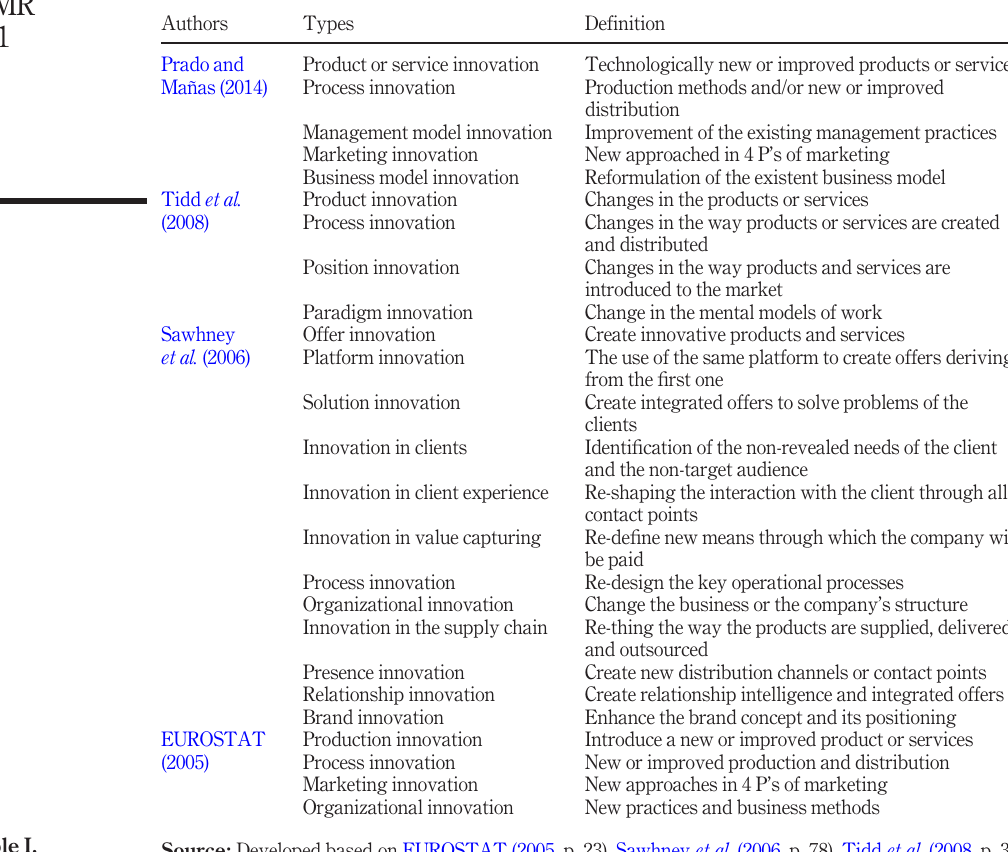
Table I. Types of